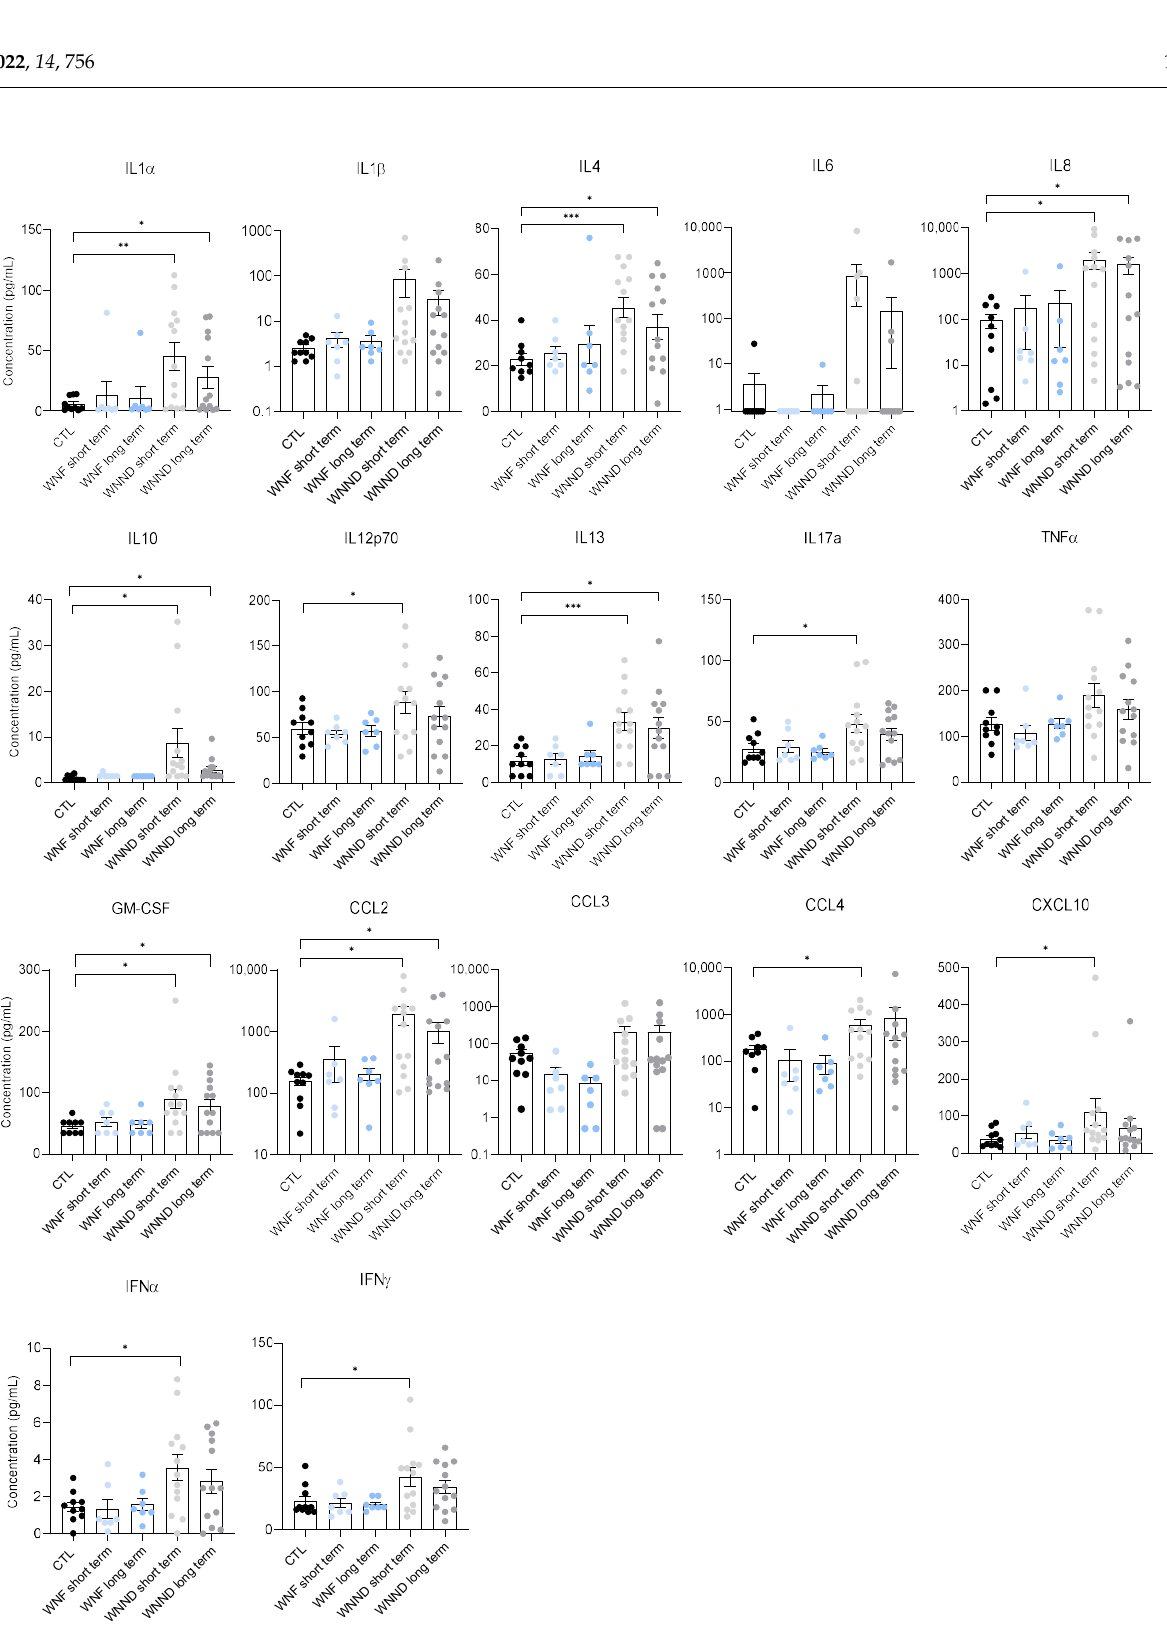
Figure 5. Persistence of inflammation in WNND patient sera. Plasma concentration in pg/mL of dif- ferent pro-inflammatory markers of non-infected CTL (black), WNVF-short term (light blue), WNVF- long term (dark blue), WNVND-short term (light grey) and WNVND-long term (dark grey) humans, measured by multiplex bead-based ELISA. Bars show means ± SEM ((short term = 2 to 11 days, long term = more than 20 days); * p < 0.05 ** p < 0.01 *** p <